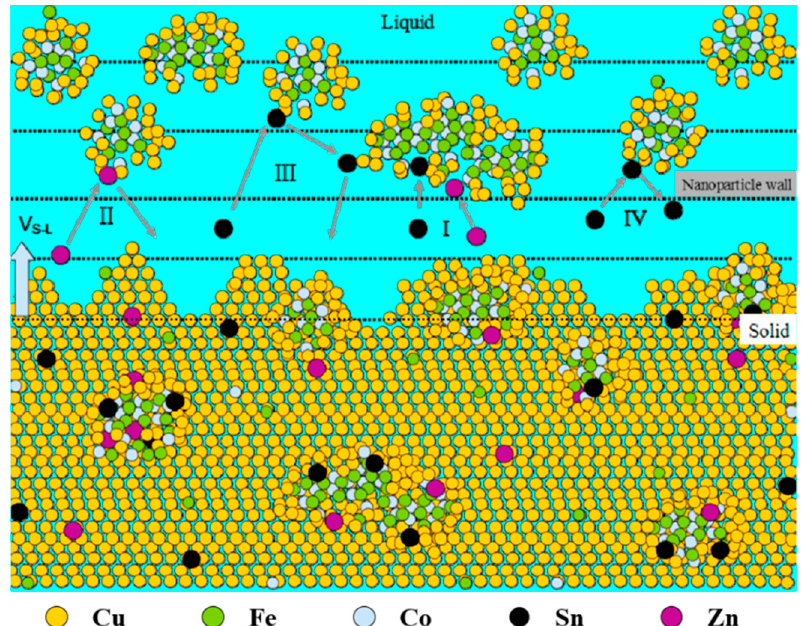
Figure 9. Schematic diagram of inhibiting Sn segregation by densely distributing iron-rich nanoparticles near solid/liquid interface (situation I: Sn and Zn atoms are absorbed on the surface of nanoparticles; situation II: Sn and Zn atoms encountered with the nanoparticles rebounded; situation III, IV: the rebounded Sn atoms are captured by advancing the S/L interface.), reprinted with permission from ref. [74], 2022, Elsevier.